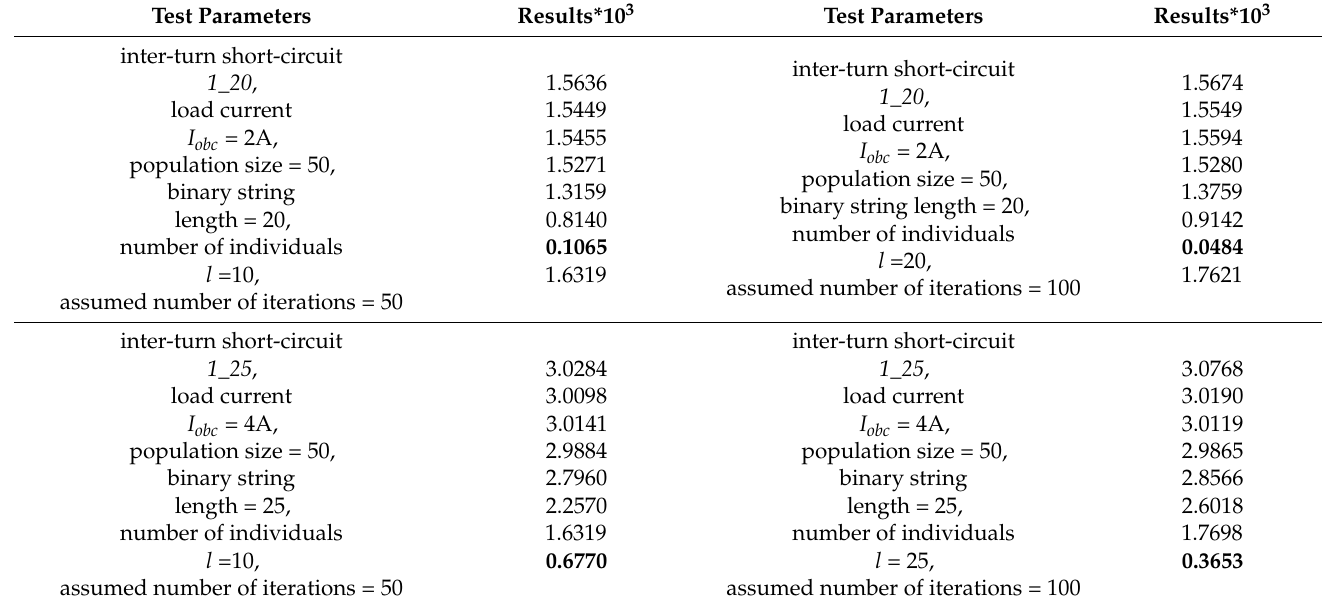
Table 2. Example results of matrix H 1 tests for rotational speed n l